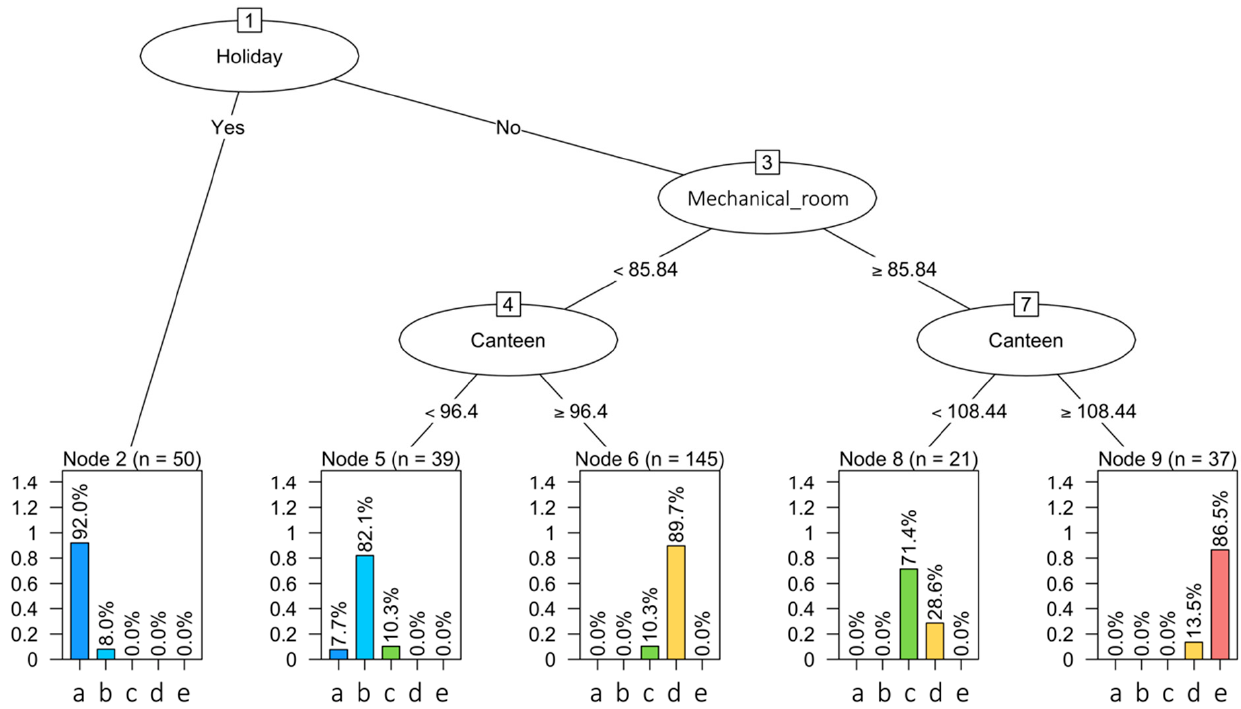
Figure 10. Globally optimum classification tree for the second time window (06:30–08:59).